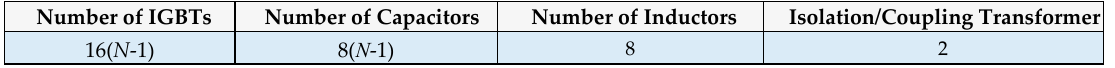
Figure 13. RPC based on a full-bridge indirect modular multilevel converter (HB-MMC4 RPC) with isolation transformers (based on [57]). Table 10. Components quantities of the HB-MMC4 RPC.